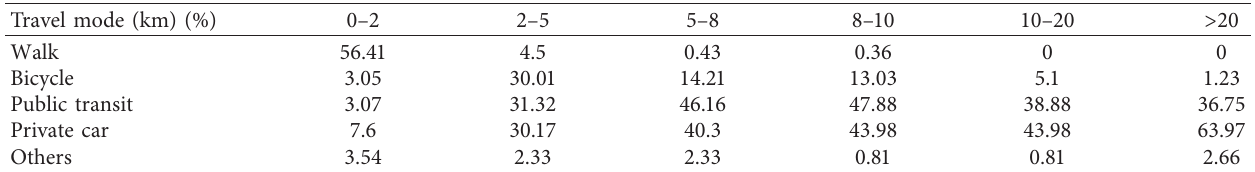
Table 6: Travel mode selection and travel distance